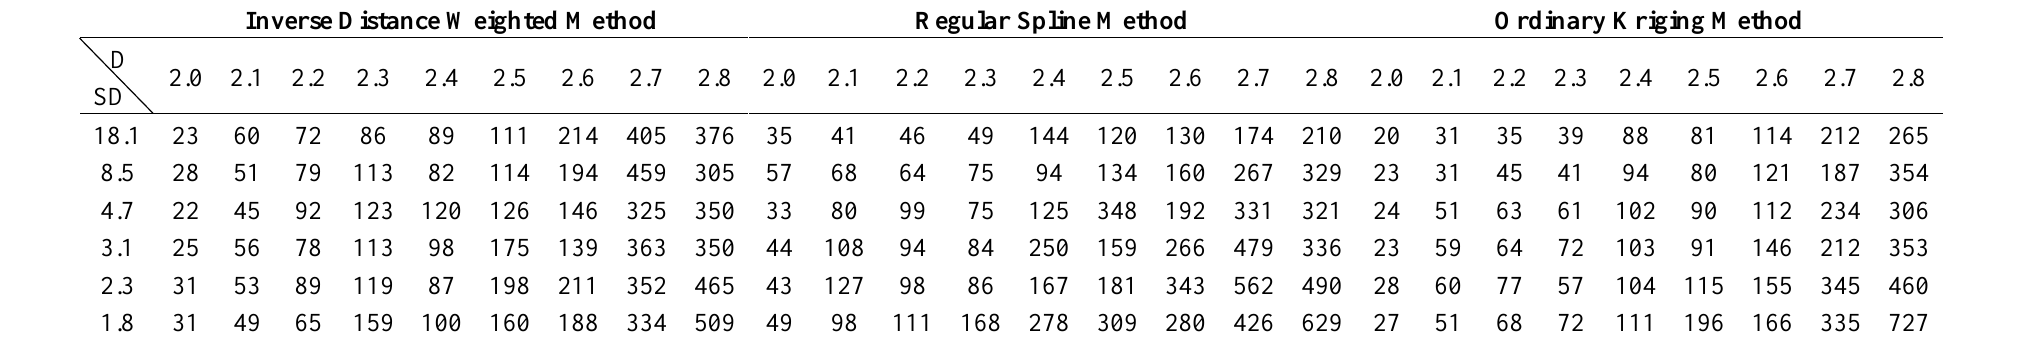
Table 2. The MAX s under selective sampling mode (Unit: